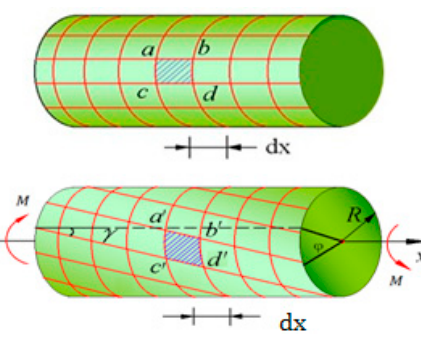
Figure 1. Experimental scheme.